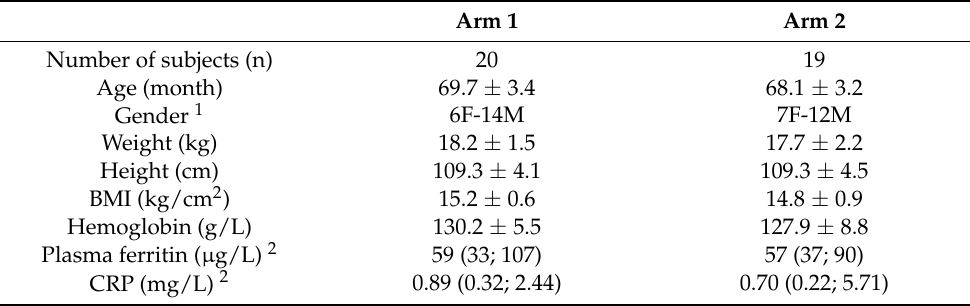
Table 1. Subjects’ characteristics for the 2 study arms (Mean ± SD, unless otherwise